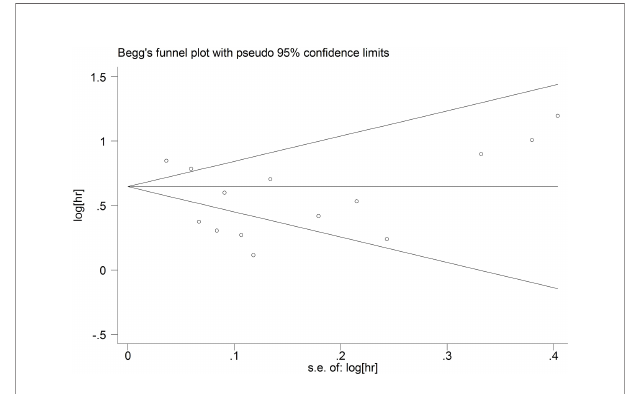
FIGURE 7 | Publication bias for OS.